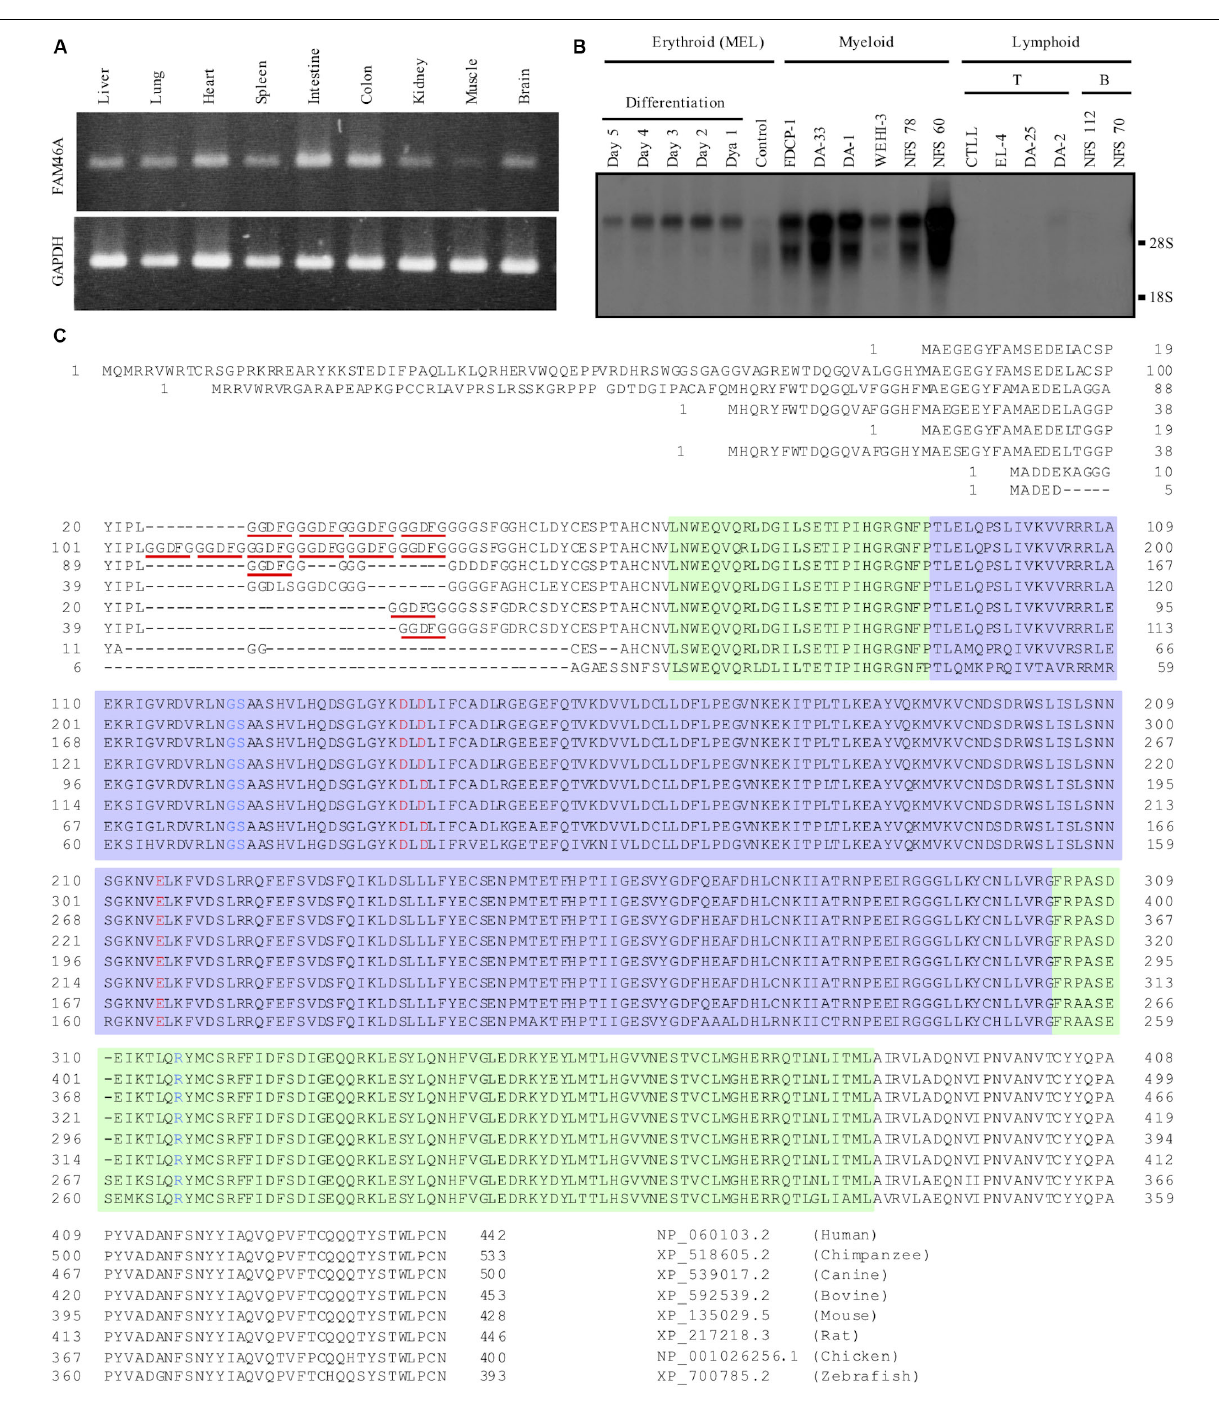
FIGURE 1 | Expressional and structural analyses of FAM46A. (A) RT-PCR analysis of Fam46a mRNA expression in various mouse tissues as indicated. The strongest Fam46a RNA expression was detected in the intestine and colon. Expression of the ubiquitous glyceraldehyde 3-phosphate dehydrogenase (GAPDH) was included as a control (lower panel). (B) Northern blot analysis of total RNAs (15 µ g/lane) isolated from various mouse hematopoietic cell lines as indicated. Fam46a was highly expressed in the myeloid cell lines, but absent in lymphoid cell lines tested. Fam46a was induced during the terminal differentiation and maturation of the mouse erythroid cell line (MEL) treated with DMSO. (C) Sequence alignment of the FAM46A protein orthologs in different animals as indicated. The protein sequences were aligned for the most sequence identity/homology match using the ClustalW program. The 5-amino acid (GGDFG) repeats encoded by the 15-nucleotide variable number tandem repeat (VNTR) was underlined in red. The predicted core NTase domain and PAP/OAS1 SBD domains are enclosed in the light purple and light green regions, respectively. The invariant active site residues involved in the catalysis of NTase were highlighted in red and the critical NTase substrate binding residues were highlighted in